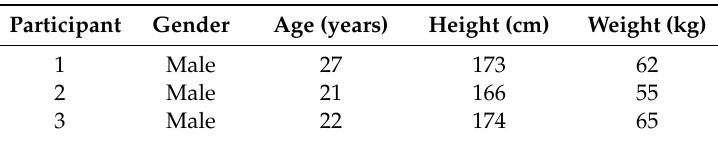
Table 3. Information of the